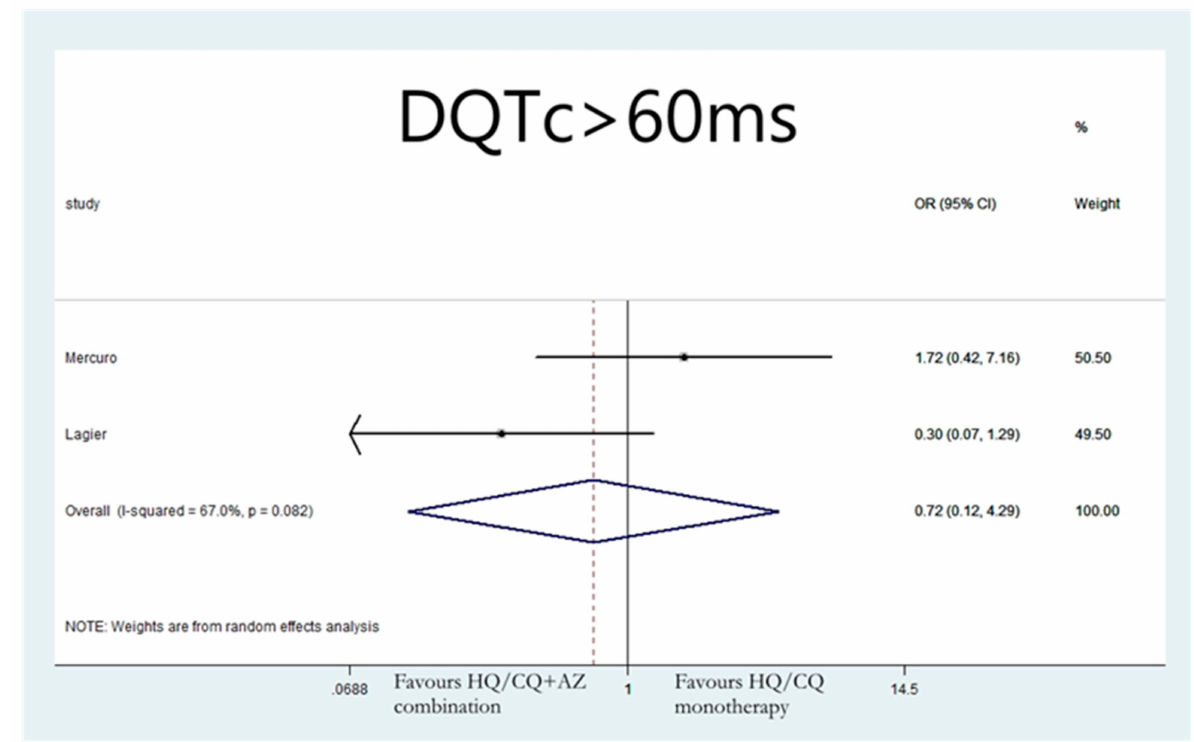
Figure 6. Risk of developing ∆ QTc > 60 ms in patients that received combination therapy with hydroxychloroquine and azithromycin vs. hydroxychloroquine monotherapy.